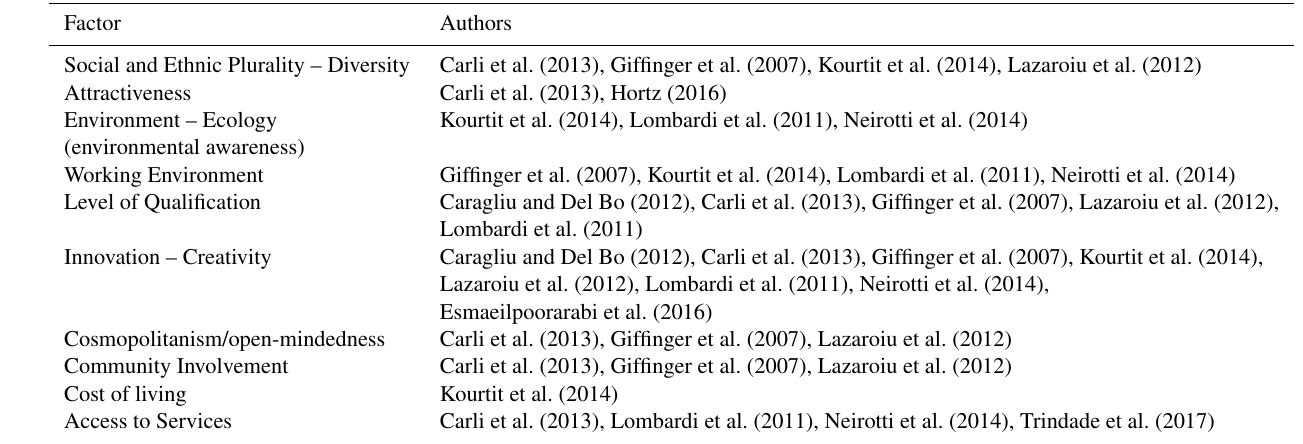
Table 1. Factors applied for human smart city